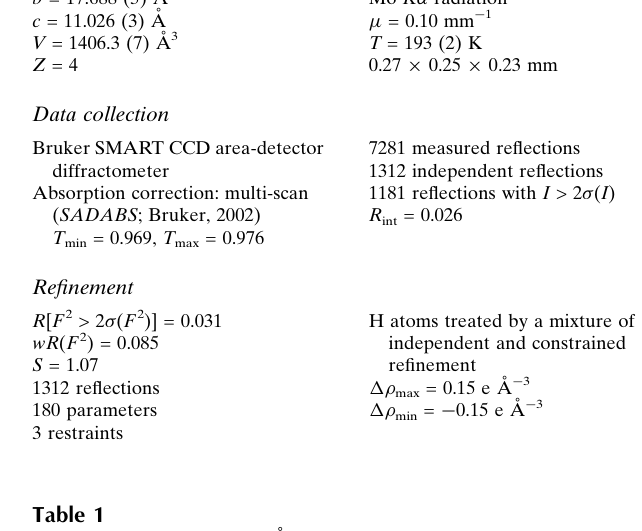
Hydrogen-bond geometry (A˚ , (cid:4)